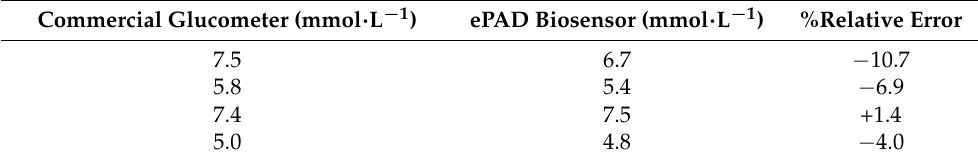
Table 1. Concentration of glucose predicted by ePAD biosensor and commercial blood glucometer.